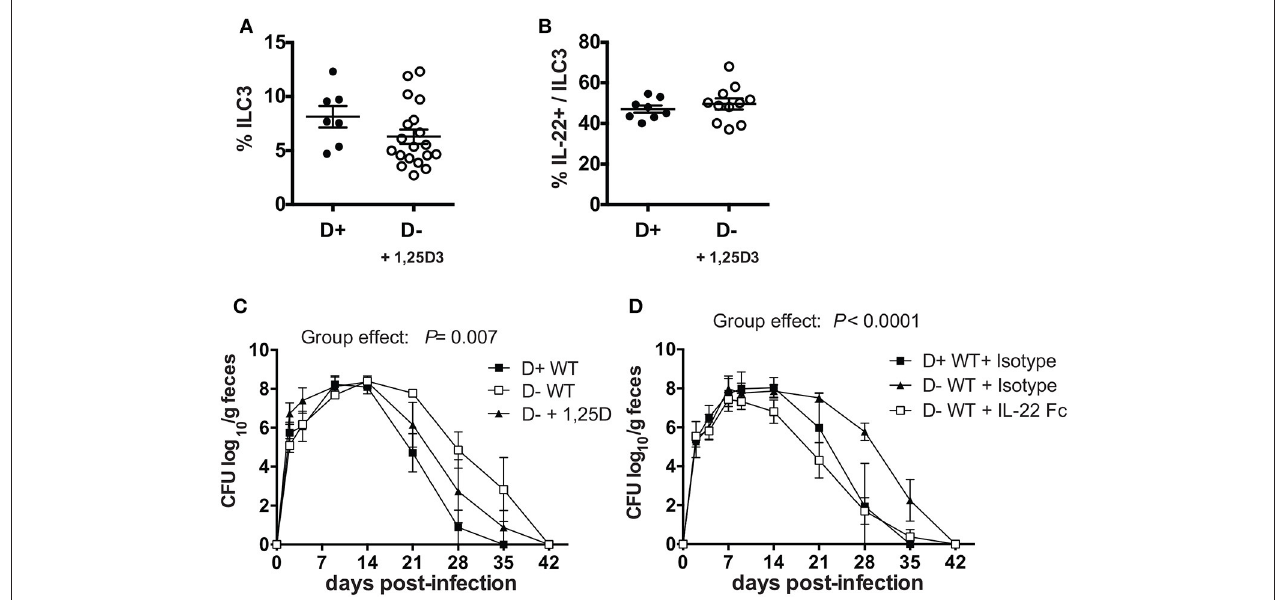
FIGURE 6 | 1, 25D treatment and IL-22 treatment of D- mice resulted in more rapid clearance of C. rodentium infection. (A) Frequencies of ILC3 cells in the colon of D- mice treated with 1, 25D. (B) Frequency of IL-22 secreting ILC3 cells following 1, 25D treatment. C. rodentium fecal shedding in D- WT mice treated with (C) 1,25D (D- + 1,25D) or (D) IL-22 treated (D- + IL-22Fc). Values are mean ± SEM of two combined experiments and (A) n = 7–19 (B) n = 8–11 (C) n = 4 (D) n = 6 – 9 mice per group. Significance was determined using two-tailed Student’s t tests (A,B) , two-way ANOVA with Tukey post-hoc tests (C,D)